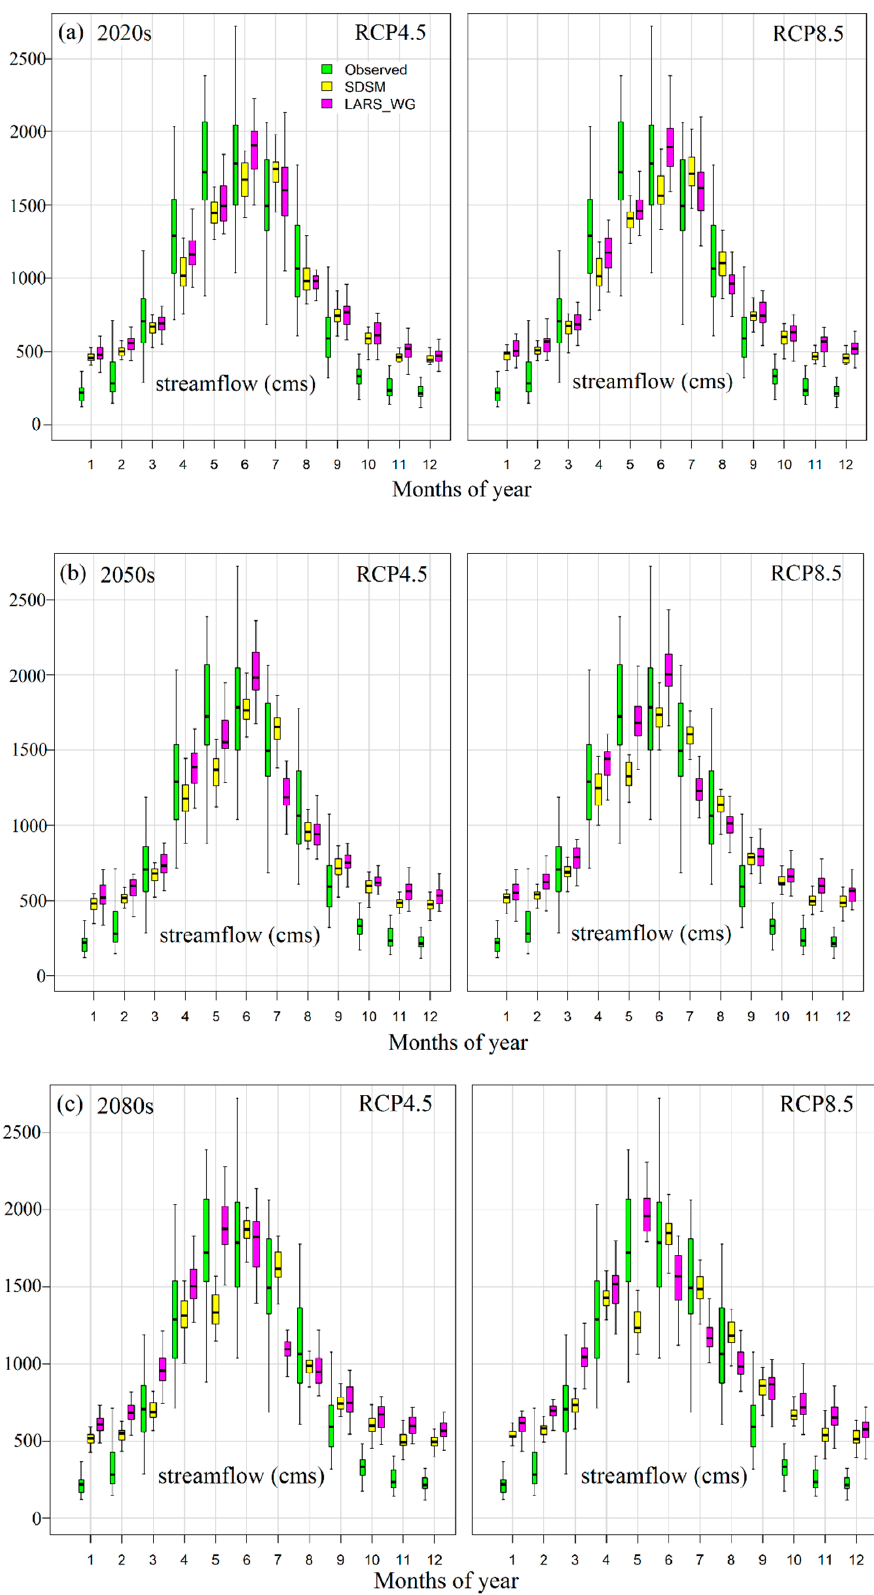
Figure 9. Boxplot of monthly streamflow (m 3 / s), comparison of observed with SDSM and LARS-WG, using RCP4.5 and RCP8.5 under three future periods ( a ) 2020s, ( b ) 2050s, and ( c )